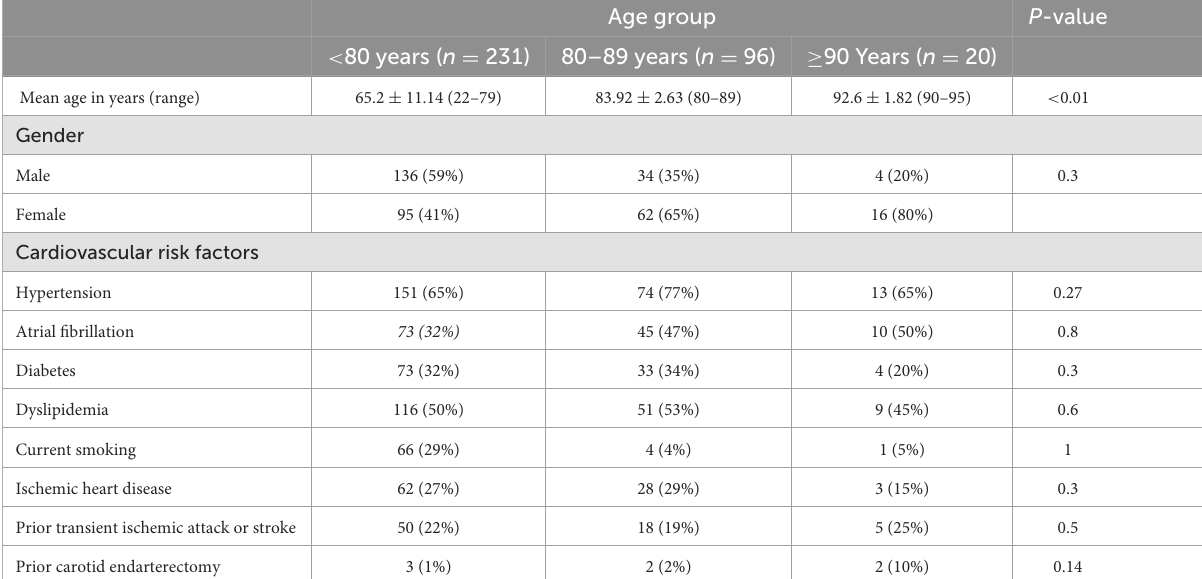
TABLE 1 Baseline characteristics.